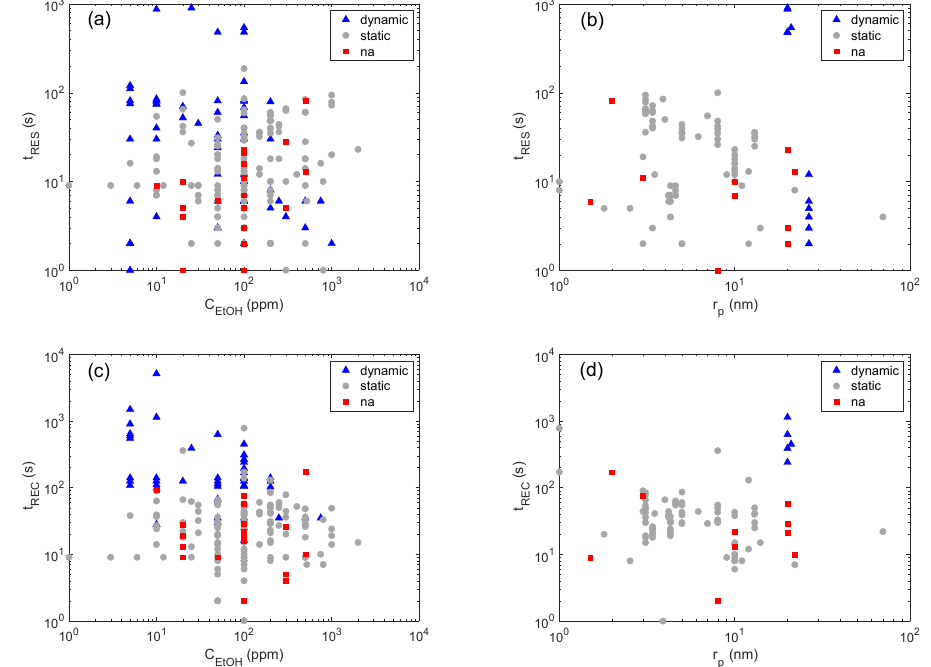
Figure A1. Ethanol concentration (C EtOH ), pore radius (r p ) and measurement setup effects on the response (t RES ) and recovery (t REC ) times. Plots are t RES vs C EtOH ( a ), t RES vs r p ( b ), t REC vs C EtOH ( c ) and t REC vs r p ( d ). In all plots, colors are used to distinguish different measurement setups, and ‘na’ stands for ‘not available’. Figure A2 reports the dependence of the sensor transient response (t RES ) and recov- ery (t REC ) on the size of the sensor chamber and the adopted flow. First of all, it is worth noting the following: (i) while the chamber value is often declared in the case of static setups, it is not for dynamic setups. Only a few papers employing a dynamic setup de-